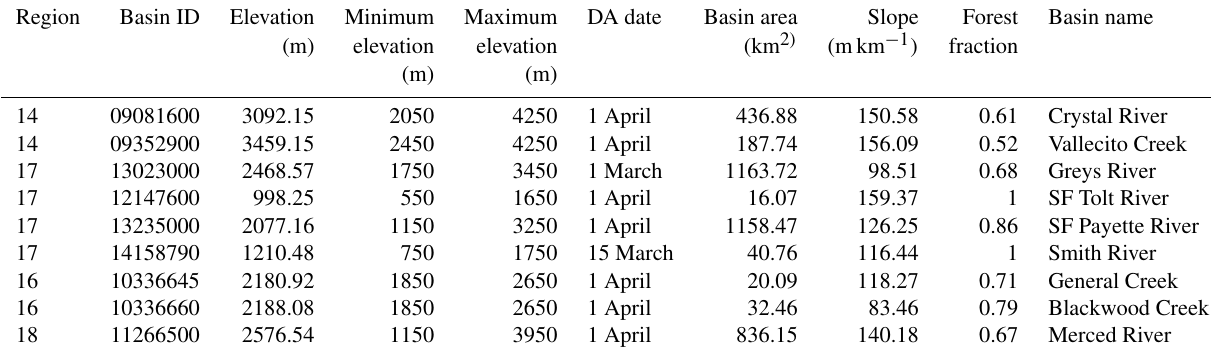
Table 1. Basin features of nine case